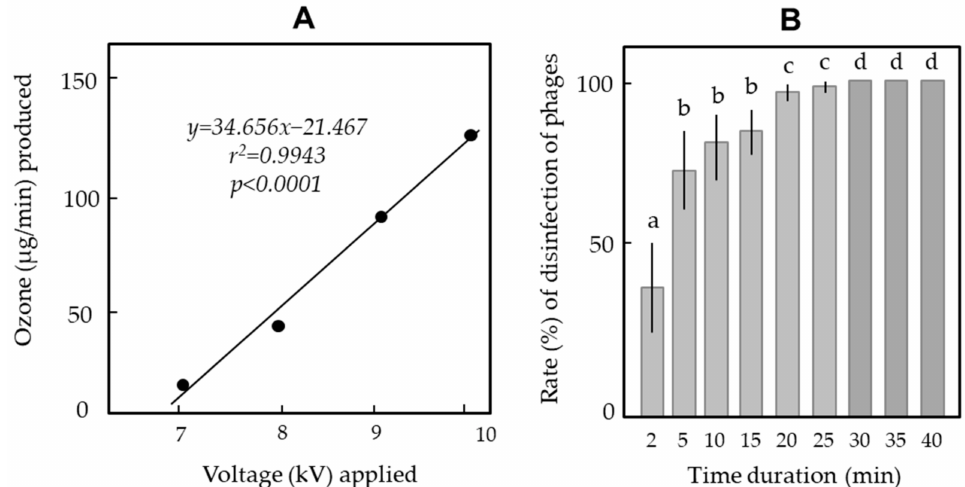
Figure 6. Positive correlation between ozone productivity and voltage applied to the ozone generator ( A ) and change in the fatality rate with time of phages exposed to microbubbles produced by the ozone generator (10-kV charge) ( B ). The means and standard deviations in ( B) were calculated from five repetitions of the experiments. The letters (a–d) on each column indicate significant differences ( p < 0.05) according to Tukey’s